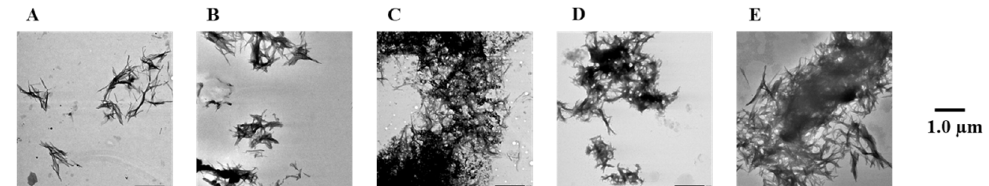
Figure 9. Efficacy of compounds 1 , 3 , 7 , and 8 against pre-existing hIAPP aggregates visualized by use of TEM. Scale bars: 1.0 μ m. ( A ) hIAPP + 1 , ( B ) hIAPP + 3 , ( C ) hIAPP + 7 , ( D ) hIAPP + 8 , and ( E ) hIAPP.